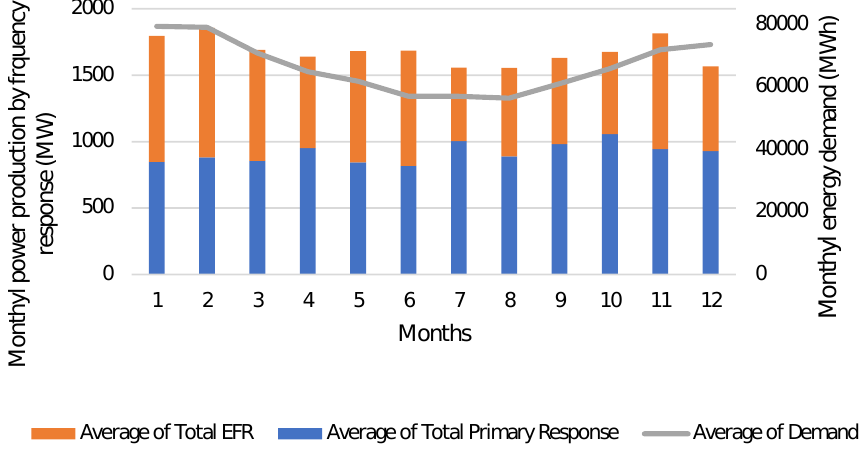
Figure 5. Monthly frequency response profile for Case study